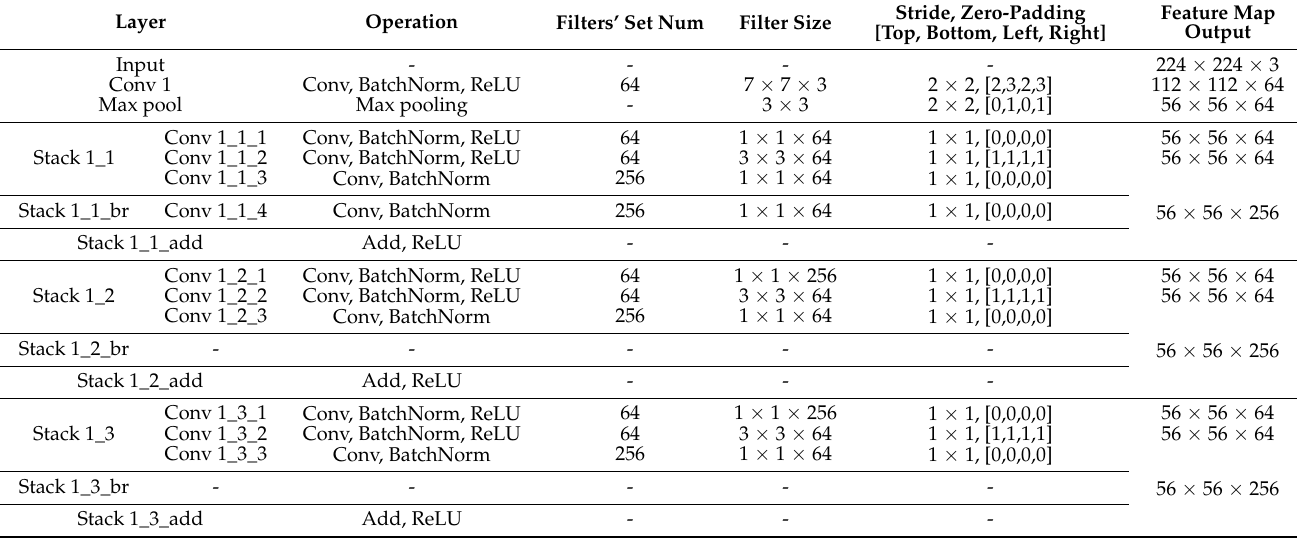
Table 1. CNN feedforward calculation from input to stack 1.